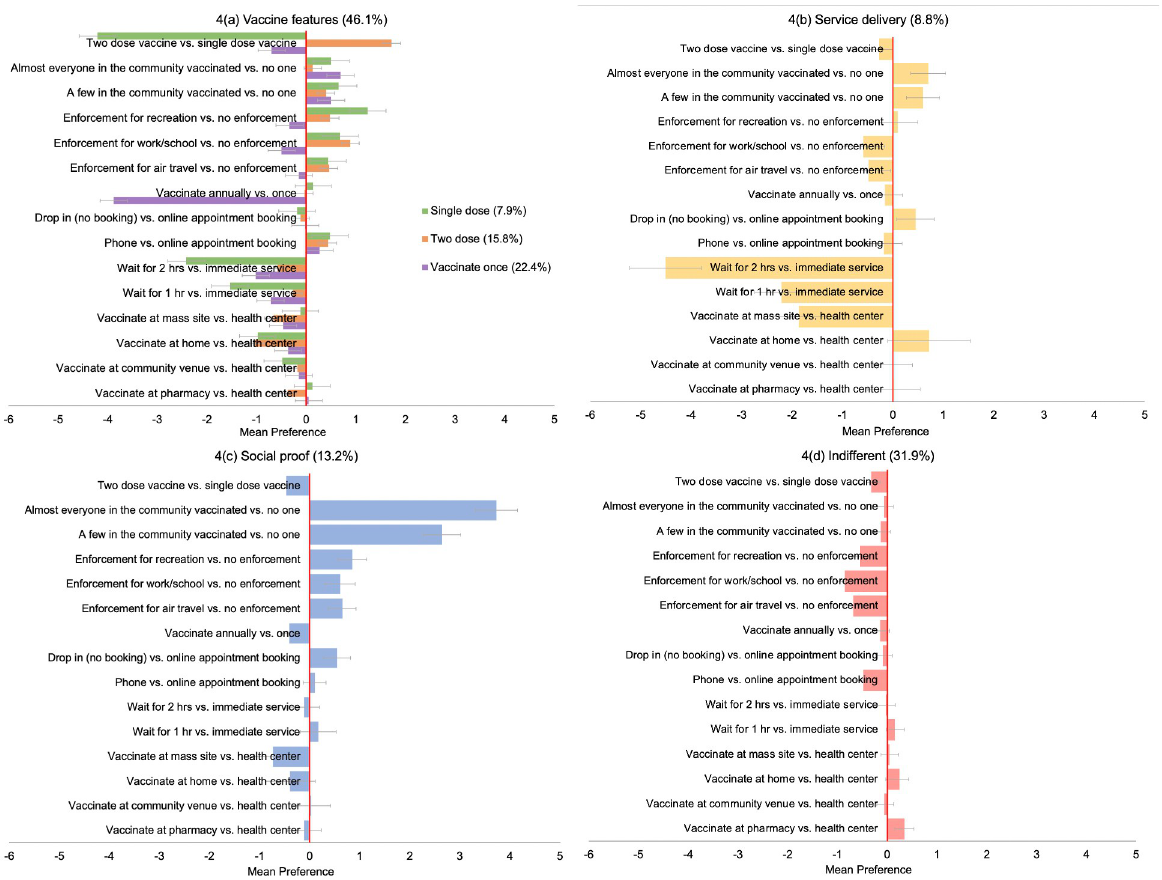
Fig 4. (a-d) Weighted mean preferences (relative utilities) for vaccination campaign features, by latent class membership group.